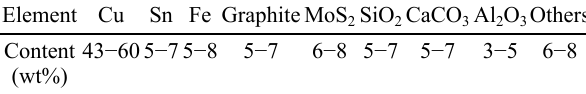
Table 2 Chemical compositions of metal-matrix friction